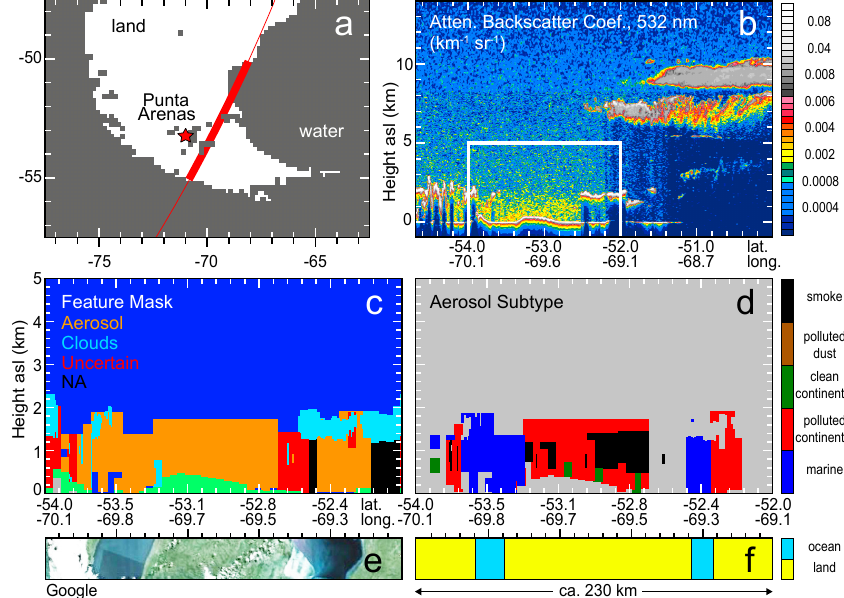
Figure 3. (a) Map of the southernmost part of South America. The thin red line shows the CALIOP night overflight on 13 January 2010. The red star indicates Punta Arenas. The thick red-line segment indicates the selected time period of CALIOP in best agreement to the Polly XT observation. (b) Height–time display of the lidar attenuated backscatter at 532nm of the CALIOP observation at 04:47UTC on 13 January 2010 (for the thick red-line period in a ). (c) Height–time display of the vertical feature mask and (d) the aerosol subtype mask of the highlighted data subset in (b) . Surface type information from the (e) Google Earth map and (f) the International Geosphere-Biosphere Programme (IGBP, 1990).